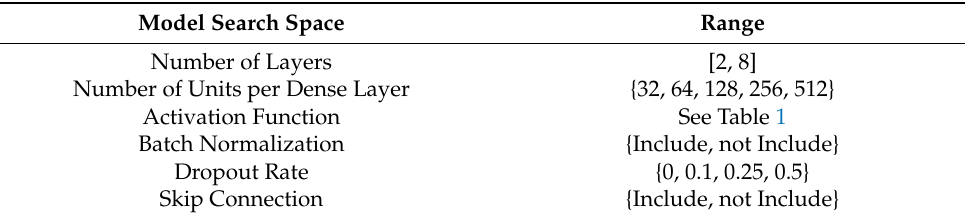
Table 3. The model search space of a fully connected neural network. It was used by DARTS, regularized evolution, and TPE NAS algorithms.